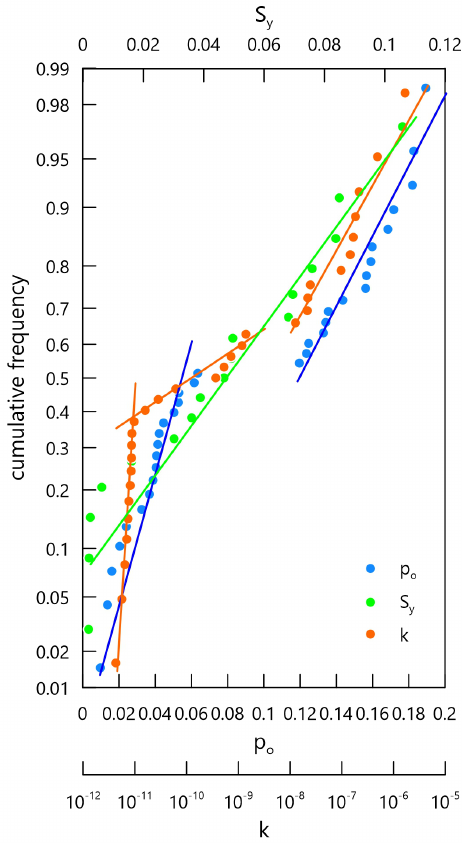
Figure 14. Cumulative frequencies of p o , S y , and k